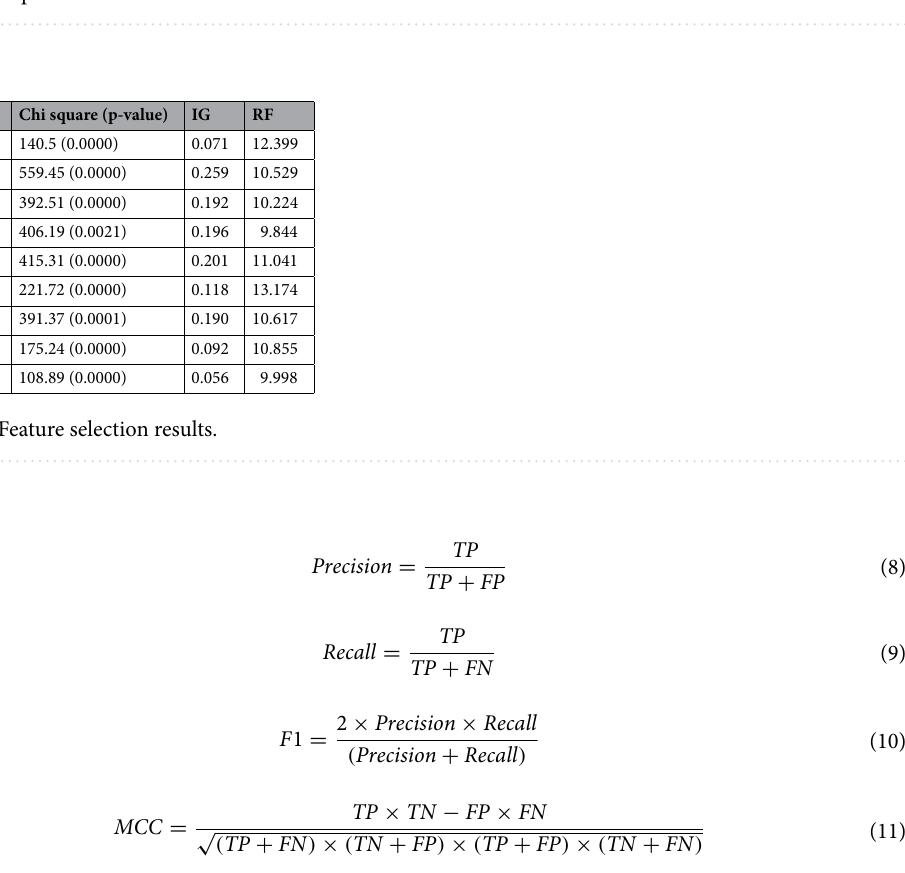
Table 2. Experiment environment.